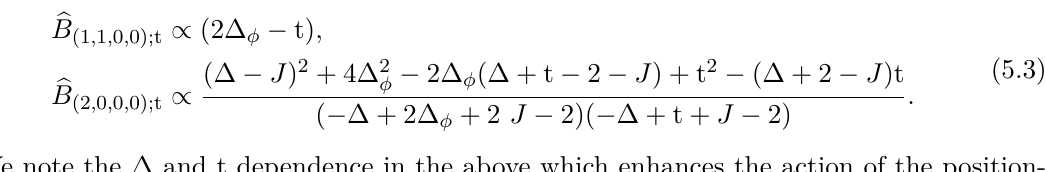
for the h σσσσ i correlator acting on conformal blocks G Figure 4 . Action of B k ;1 | 34 spin J , twist τ = ∆ − J and subtraction schemes k = (1 , 1 , 0 , 0) and (2 , 0 , 0 , 0) represented as blue and orange curves respectively. Red dotted vertical lines denote double-twist values while vertical cyan lines denote the Ising model operators appearing in the OPE of h σσσσ i